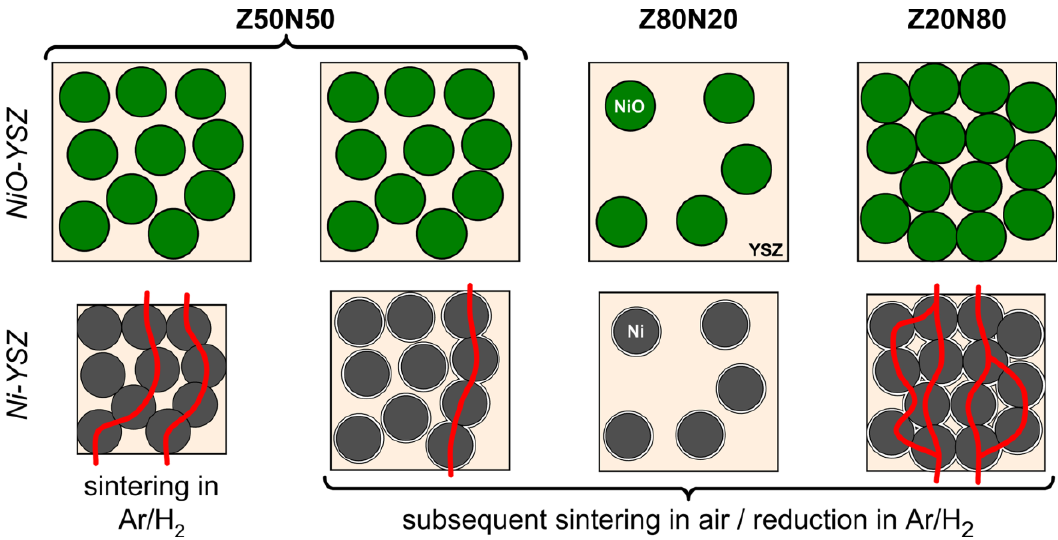
Figure 9. Schematic representation of the evolution of conduction pathways (red) in the microstructure of Ni–YSZ cermets as a function of the NiO content and the sintering conditions. The sample Z50N50-1400sH 2 , which was sintered directly in hydrogen-containing atmosphere, − 1 represents an exceptional position. The electric conductivity is 4.2 × 10 3 S · m and more than